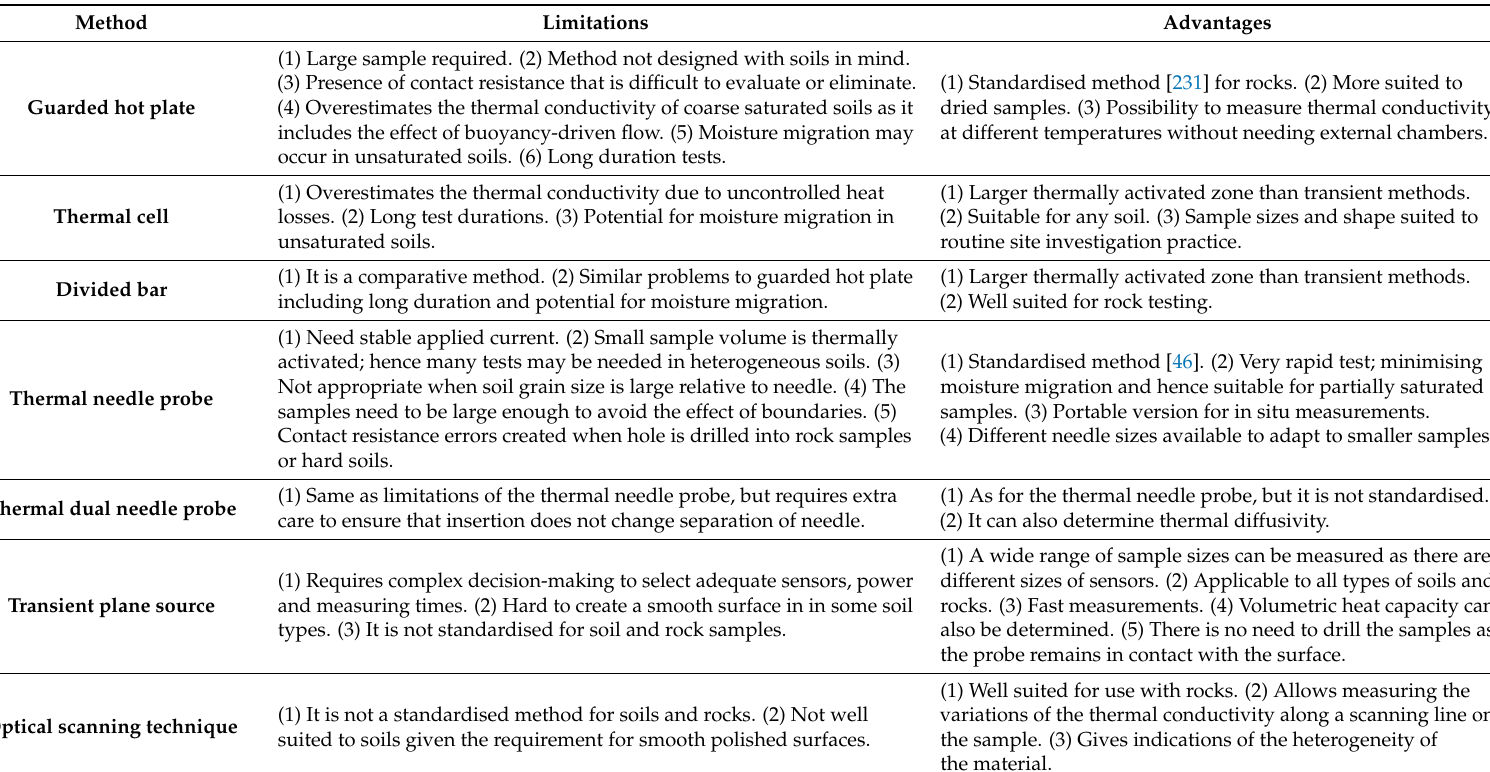
Table A1. Summary of the advantages and disadvantages of each technique used for measuring soil and rock thermal